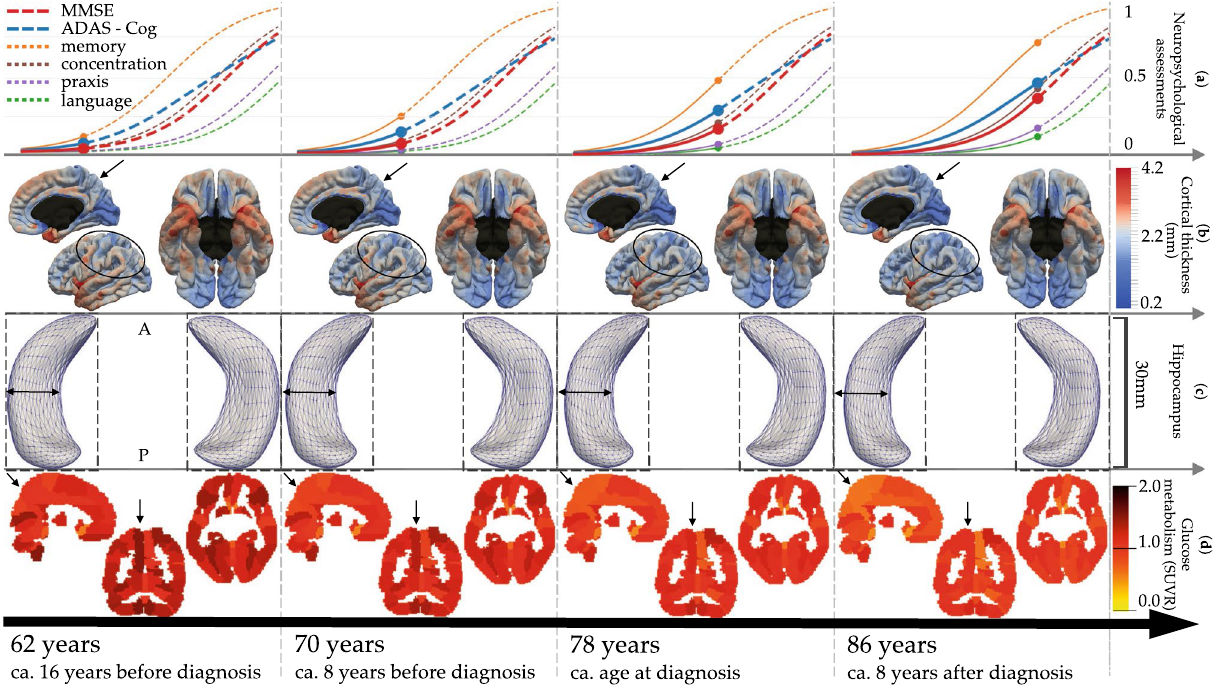
Figure 2. Normative models of Alzheimer’s disease progression shown at 4 Alzheimer Age with estimated time until/from diagnosis. Bottom to top rows show alteration of brain glucose metabolism, hippocampus atrophy, cortical thinning and onset of cognitive decline. Black arrows and ellipses indicate some areas of great changes. Images were obtained using the freely available software FSLeyes v.0.22.6 (https:// fsl. fmrib. ox. ac. uk/ fsl/ fslwi ki/ FSLey es) and Paraview v.5.2.0 (www. parav iew.